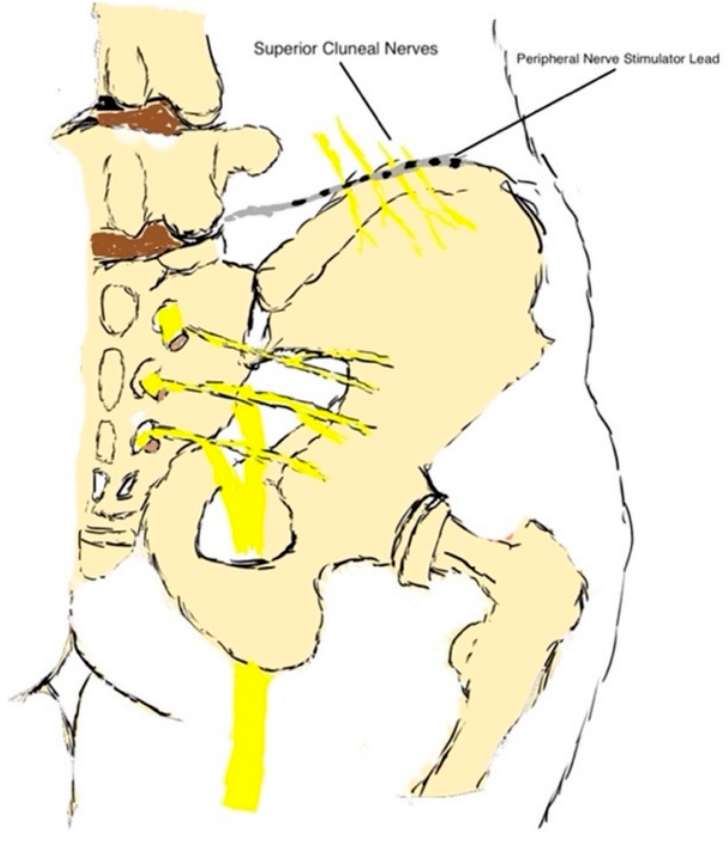
Figure 2. Implanted peripheral nerve stimulator lead.